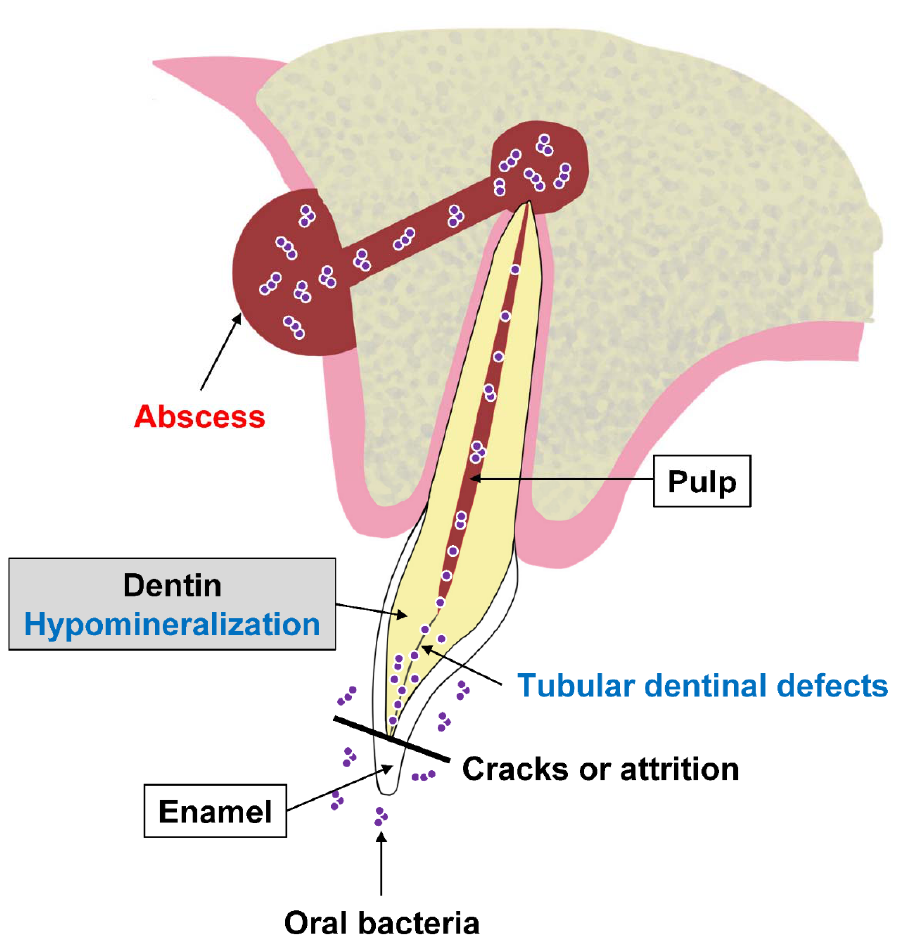
Figure 1. Clinical and radiographic dental manifestations of X ‐ linked hypophosphatemia (XLH). ( A ) Oral photograph of male patient aged 4 years 4 months showing a periapical gingival abscess (white arrow) corresponding to the primary maxillary left central incisor. ( B ) Periapical radiograph showing radiolucency (black arrow) around the periapical region of the primary maxillary left cen ‐ tral incisor.